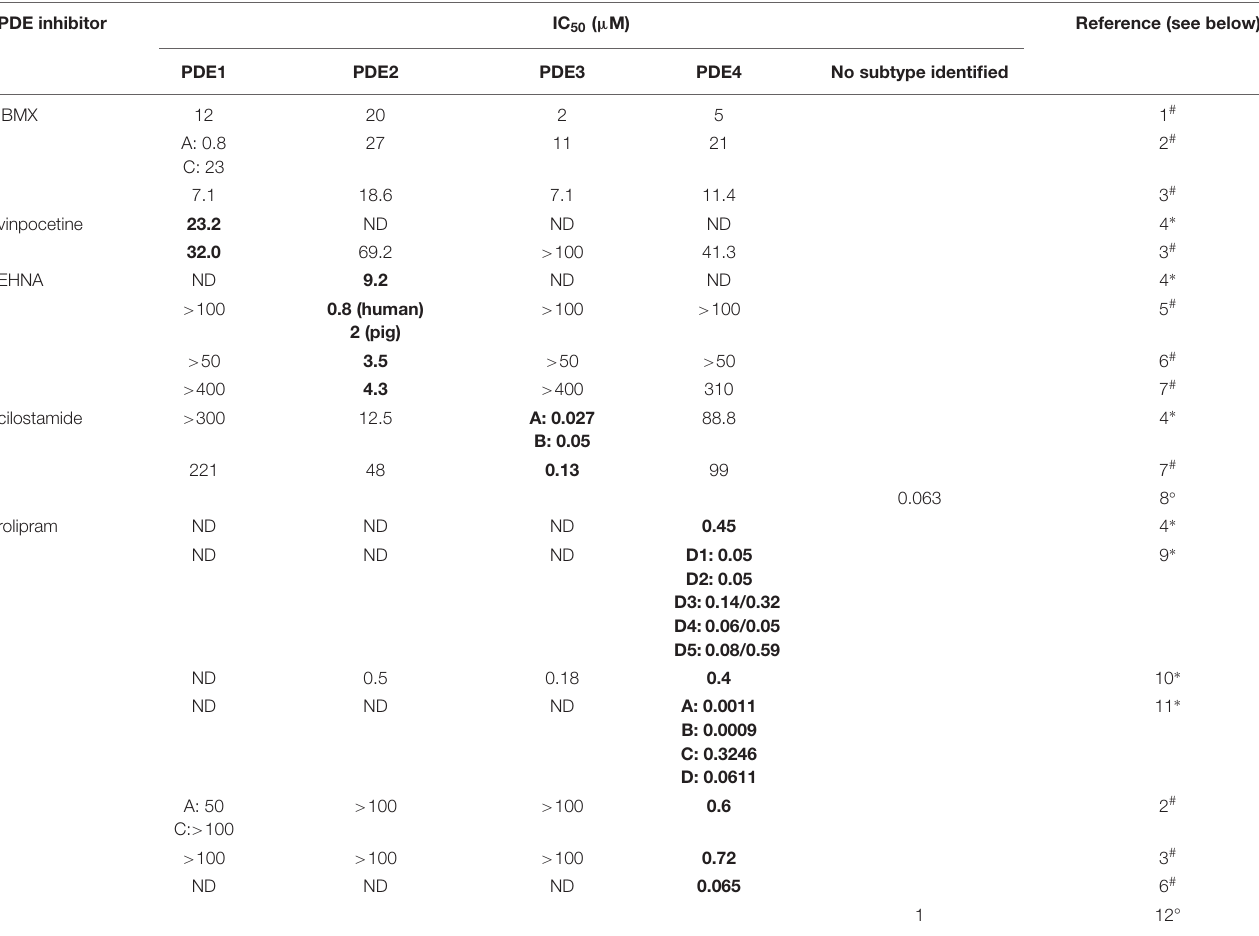
TABLE 2 | Overview of reported IC 50 values for the PDE inhibitors studied (in bold for PDE subtype, wherefore the inhibitor is considered selective). PDE inhibitor IC 50 ( µ